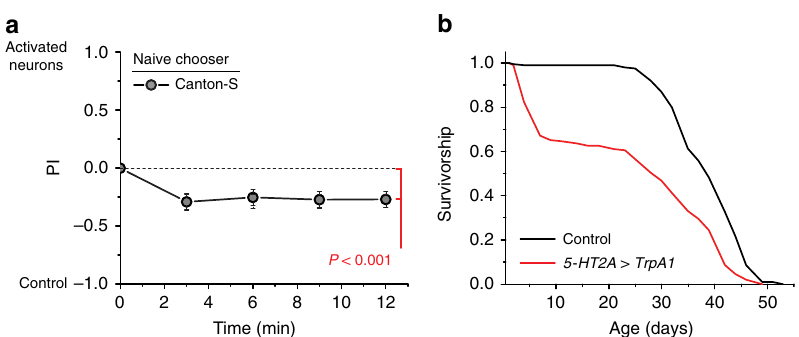
Fig. 6 Activation of 5-HT2A neurons induces aversiveness and reduces lifespan in Drosophila . Constitutive activation of 5-HT2A + neurons via expression of UAS-TrpA1 relative to 5-HT2A-GAL4; + control fl ies results in a increased aversiveness ( N = 19, P < 0.001) and b signi fi cantly decreased lifespan ( N = 194 for 5-HT2A>TrpA1 and N = 195 for 5-HT2A-GAL4; + , P < 0.001). Each T-maze sample tests 20 fl ies. Error bars represent standard error of the mean